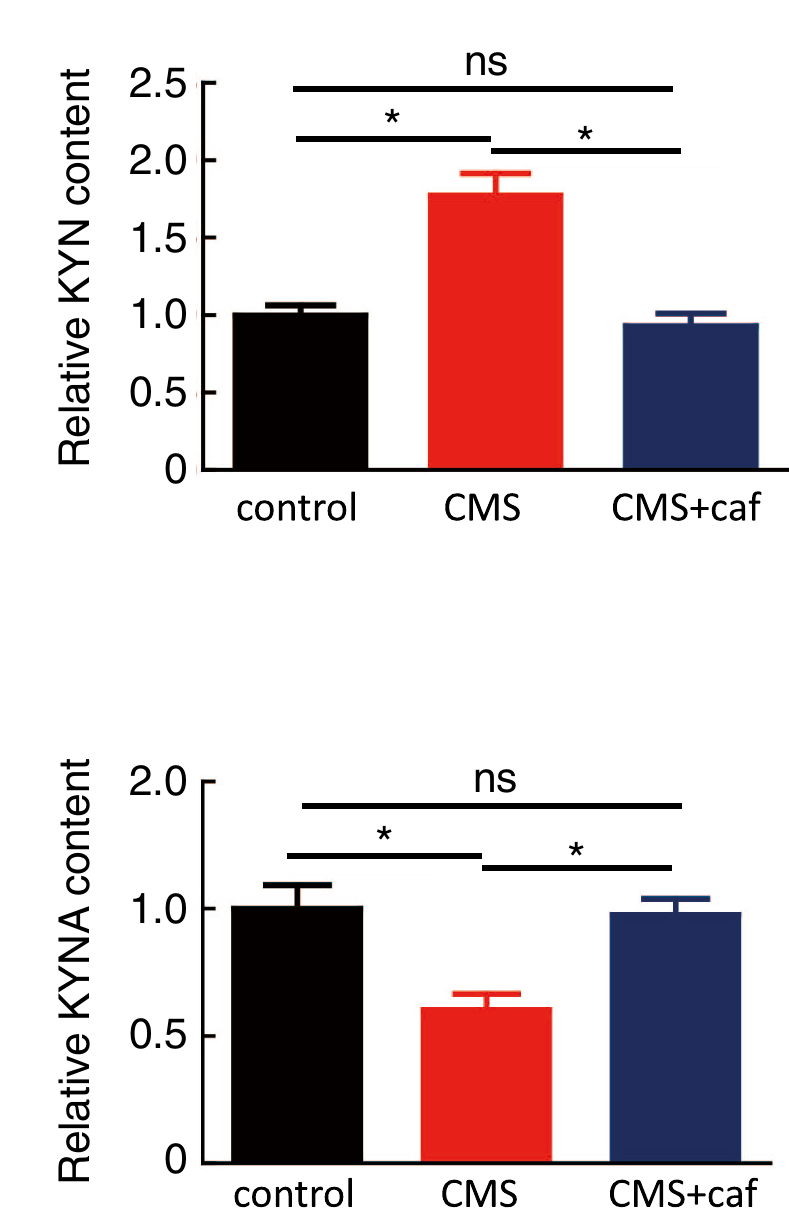
Figure 2. Caffeine restored KYN and KYNA content in plasma. Mice were exposed to CMS with drinking water supplemented with (CMS + caf) or without (CMS) caffeine. Non-CMS-exposed mice were used as controls. After tests for depression-like behaviours, shown in Fig. 1, plasma was sampled for the measurement of KYN and KYNA. Fold changes of KYN ( a ) and KYNA ( b ) to those of control mice were shown. The absolute values of KYN level were 0.28 ± 0.01 μmol/L, 0.49 ± 0.01 μmol/L, and 0.26 ± 0.01 μmol/L for control, CMS, and CMS + caf group, respectively; and the absolute values of KYNA level were 0.32 ± 0.01 μmol/L, 0.19 ± 0.01 μmol/L, and 0.31 ± 0.01 μmol/L for control, CMS, and CMS + caf group, respectively. Eight mice were used in control and CMS group, and nine mice were used in CMS + caf group. Data are shown as mean ± SEM. Similar results were obtained in two independent experiments. * p <